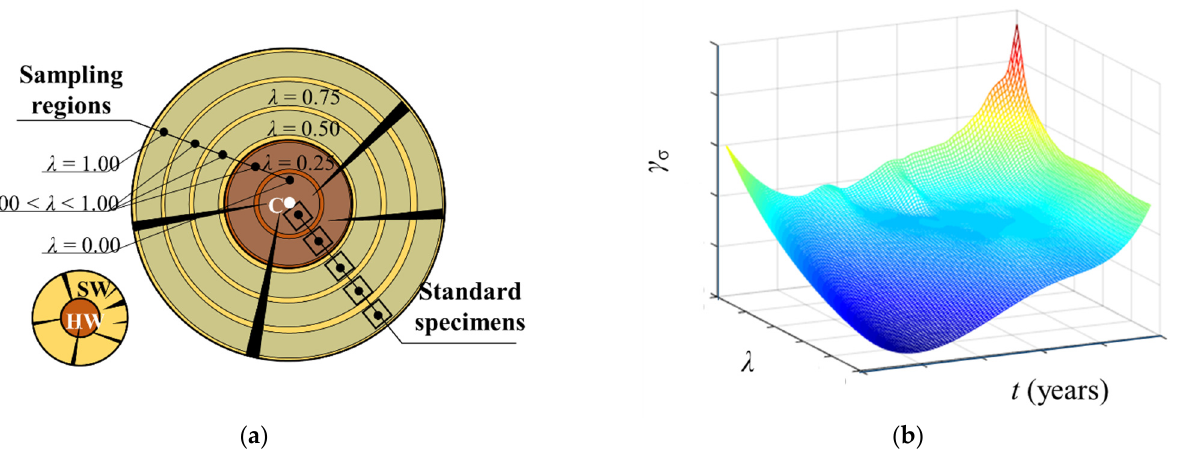
Figure 2. Schematic diagram of the relationship between the compressive strength ratio, sampling position, and age of the timber member: ( a ) definition of parameter λ ; ( b ) a 3D schematic diagram of the relationship.